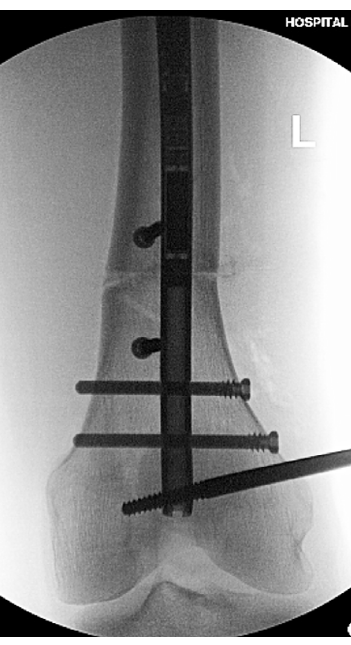
Figure 6. The AP fluoroscopy shot shows the distal femur after successful distal interlocking with the varus deformity corrected. The peri-osteotomy blocking screws are positioned to prevent varus deviation during lengthening. The external half pin is also seen in the